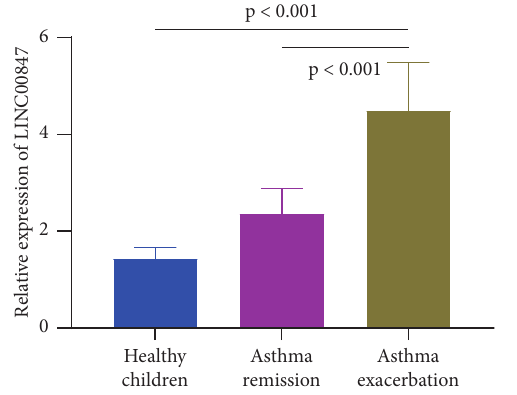
Figure 2: The expression level of LINC00847 in PBMCs of asthma exacerbation children, asthma remission children, and healthy